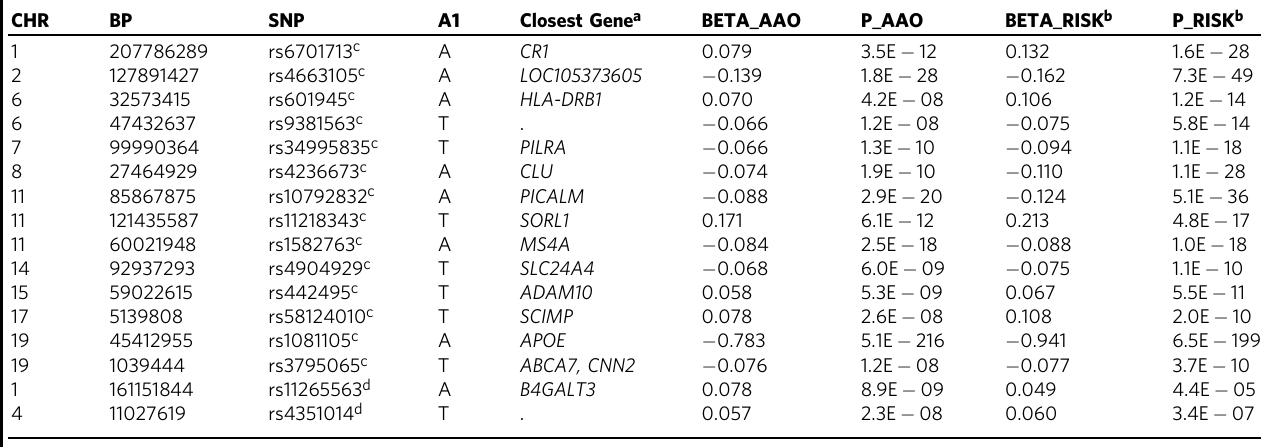
Table 2 Genome-wide signi fi cant SNPs associated with age at onset (AAO) of late-onset Alzheimer ’ s